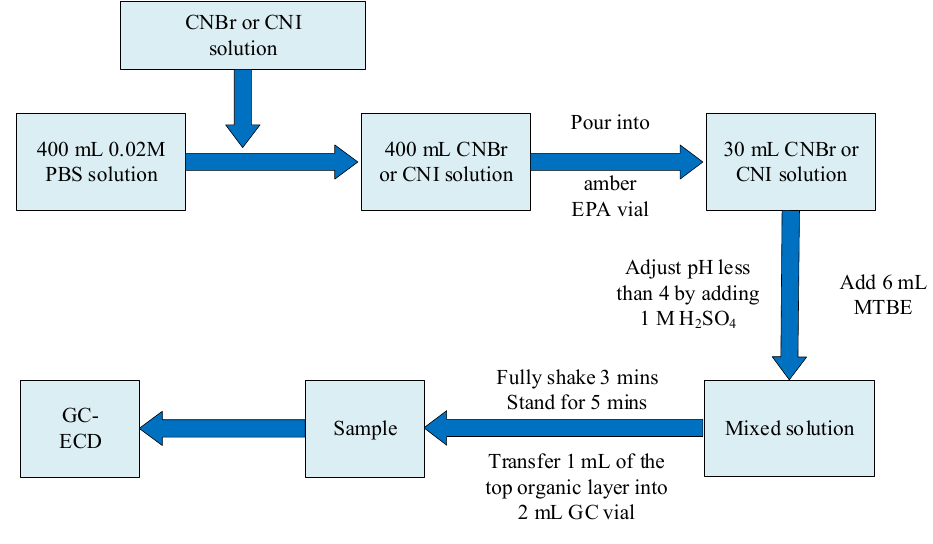
Figure 1. Flowchart of sample preparation.